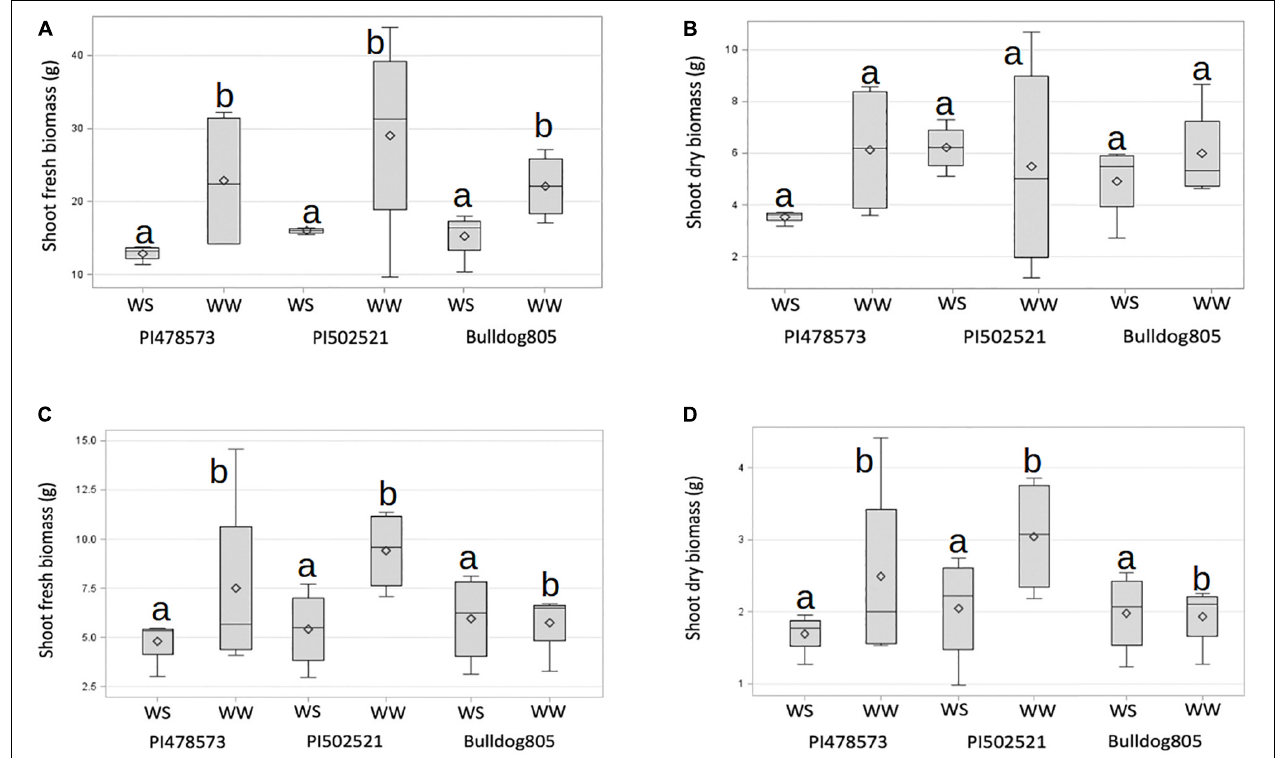
FIGURE 2 | Shoot biomass of alfalfa populations grown under well-watered (WW) and water-stressed (WS) conditions. Variation observed across treatments in Exp. 1 for shoot fresh (A) and dry weight (B) . Variation observed across treatments in Exp. 2 for shoot fresh weight (C) and dry weight (D) . The horizontal line and symbol in the box interior represents the group median and mean phenotypic values with the low and higher Quartile represent as whiskers below and above bar